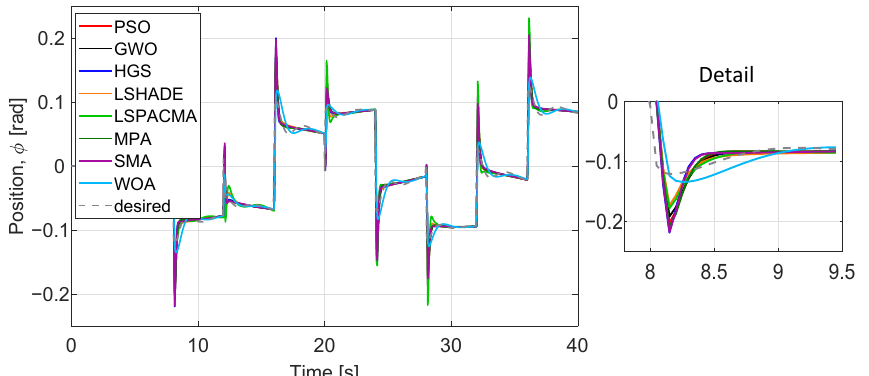
Figure 9. Comparison of tracking performance in φ –angle of the different algorithms evaluating parameters obtained with 20 individuals.